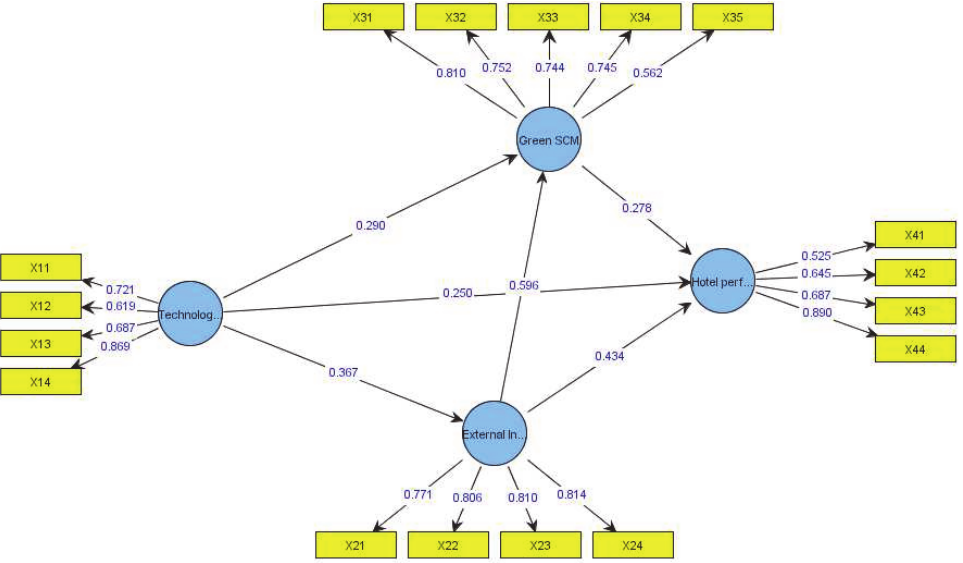
Fig. 2. The results of testing the hypotheses